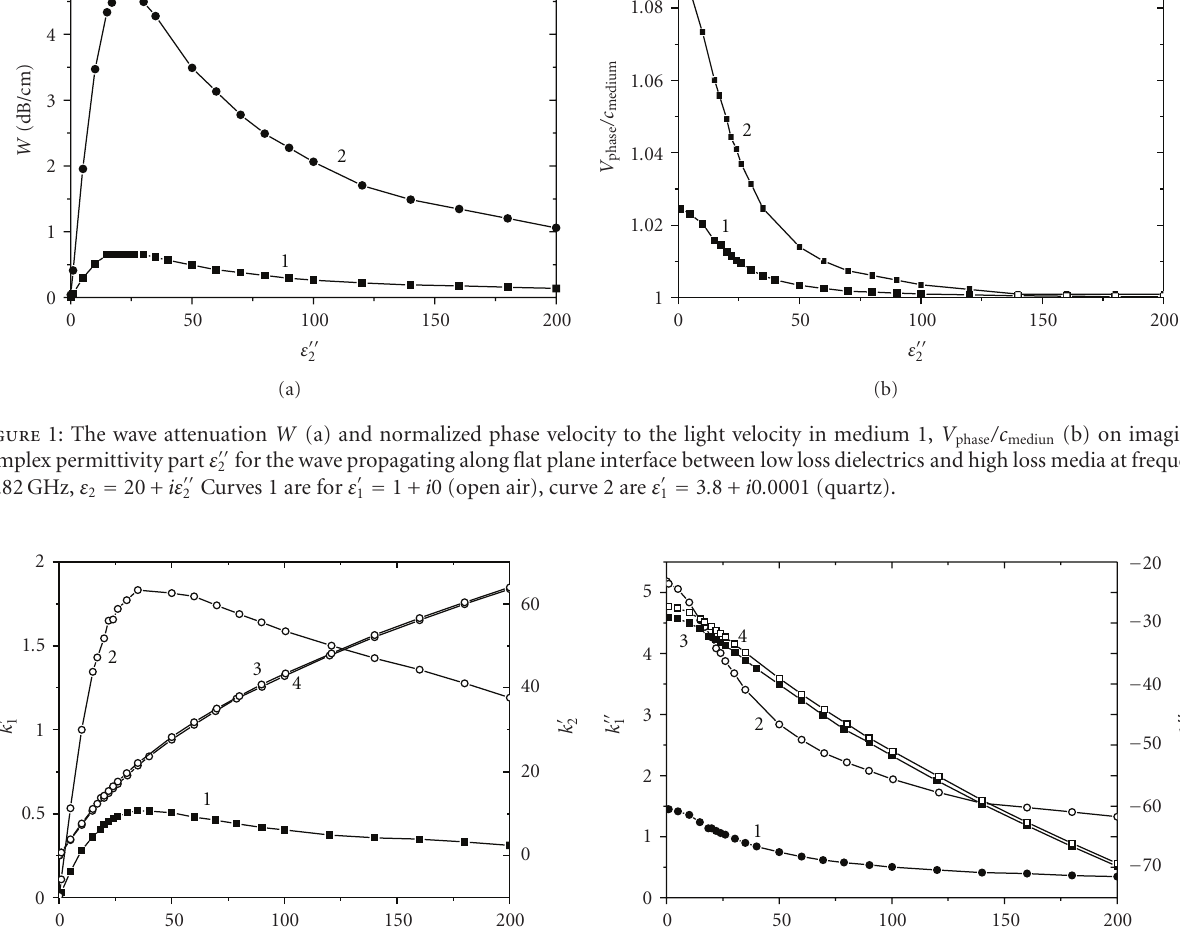
Figure 2: The dependence of real parts of wave numbers k (cid:2) wave propagating along flat plane interface between low loss dielectrics and high loss media. The operating frequency 31.82GHz. The curves 1 and 3 are for ε (cid:2) 1 = 1 + i 0 (open air), the curve 2 and 4 are for ε (cid:2) 1 = 3 . 8 + i 0 . 0001